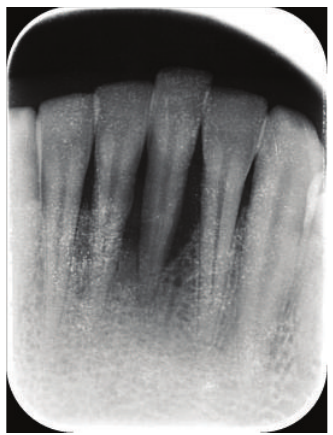
Figure 1: Preoperative radiograph.